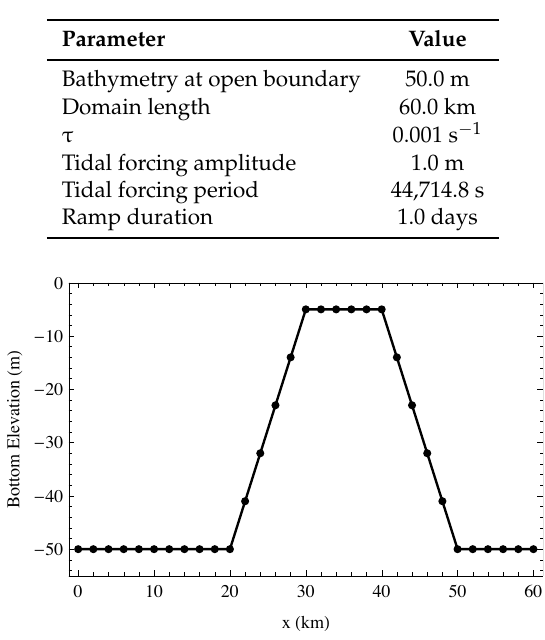
Table 2. Parameters for the seamount domain test case.